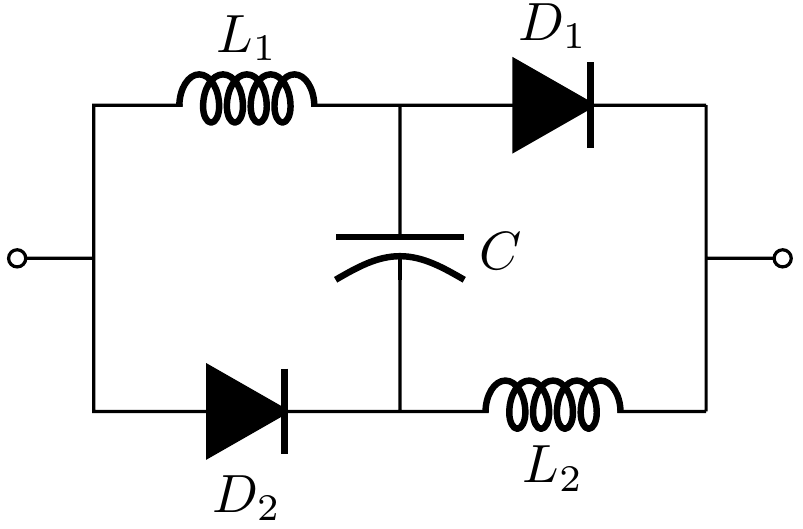
Figure 12. Basic Structure of Voltage Lift (VL)